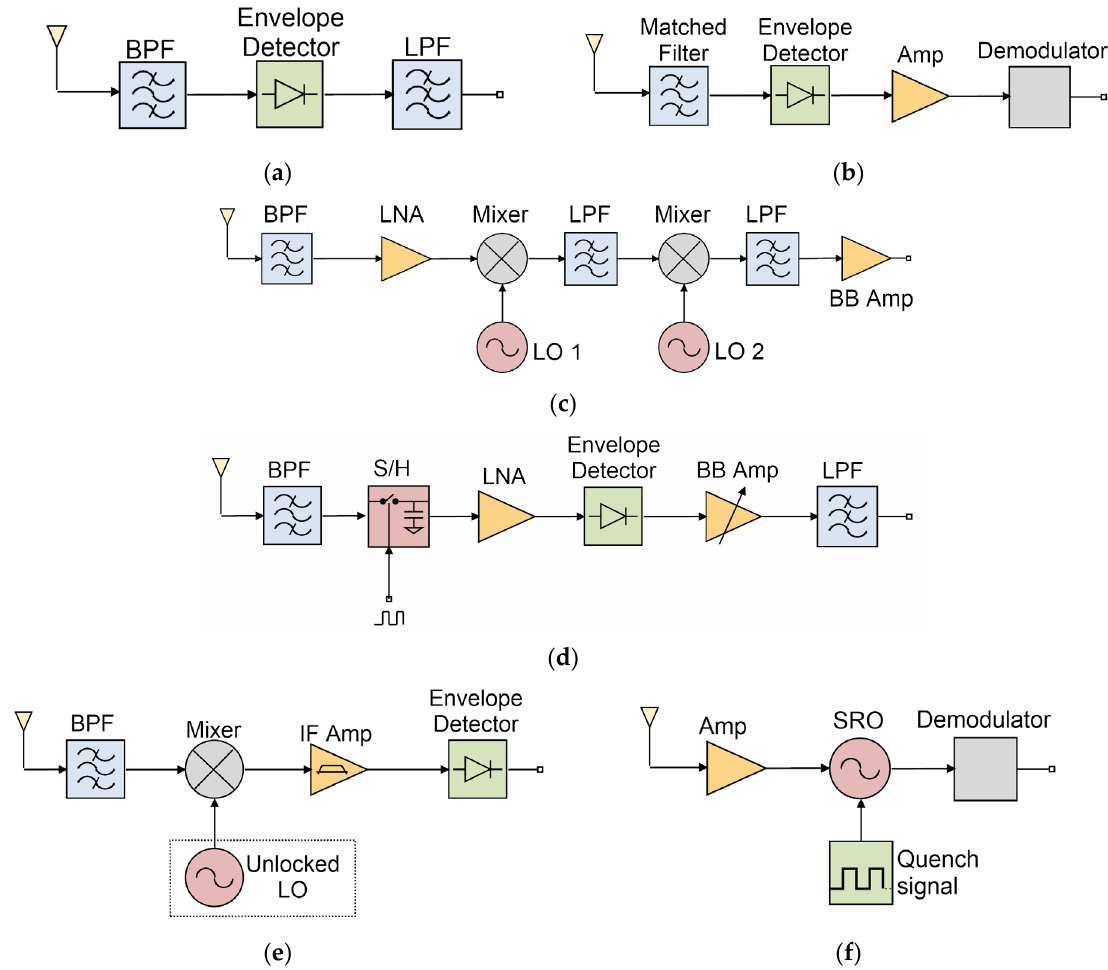
Figure 3. WuR topologies: envelope detector ( a ); matched-filter ( b ); superheterodyne ( c ); sub-sampling ( d ); uncertain-IF ( e ); and super-regenerative ( f ); and architectures.